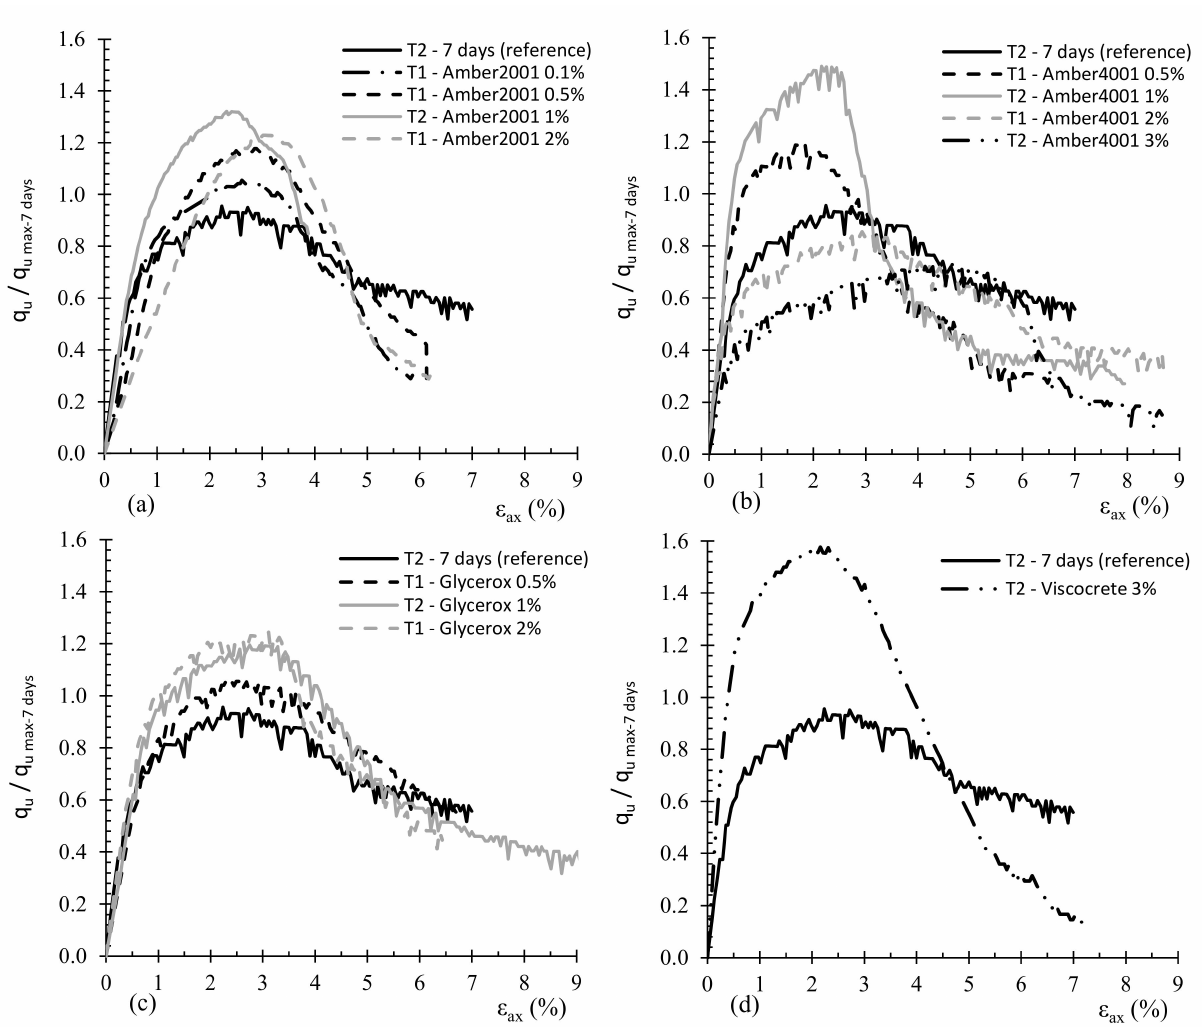
Figure 3. Stress–strain normalized curves (for samples with 7 curing days) for the stabilized soil with only a surfactant solution of ( a ) Amber 2001, ( b ) Amber 4001, ( c ) Glycerox and ( d )